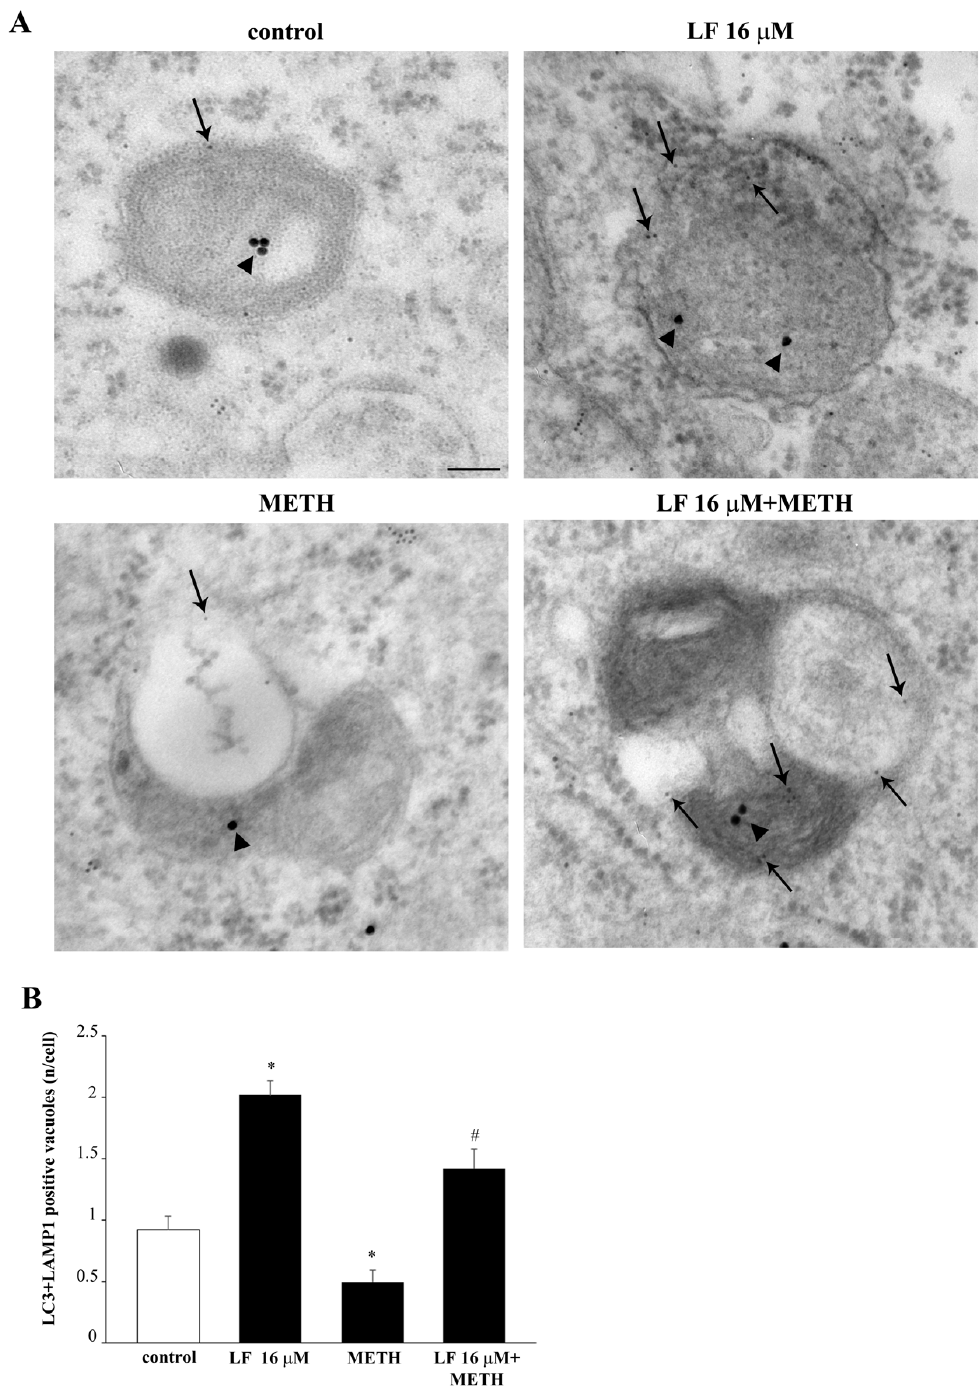
Figure 17. LF increases LC3 and LAMP1 co-localization within vacuoles. ( A ) Representative TEM pictures of LC3 and LAMP1 positive vacuoles from a control cell, and cells treated with either LF 16 µ M or METH or LF + METH. Arrowheads and arrows point to LC3 (20 nm) and LAMP1 (10 nm) immuno-gold particles within vacuoles, respectively. The graph ( B ) reports the number of vacuoles double-stained with LC3 and LAMP1 immuno-gold particles. * p < 0.05 compared with control; # p < 0.05 compared with METH. Scale bar = 100 nm.